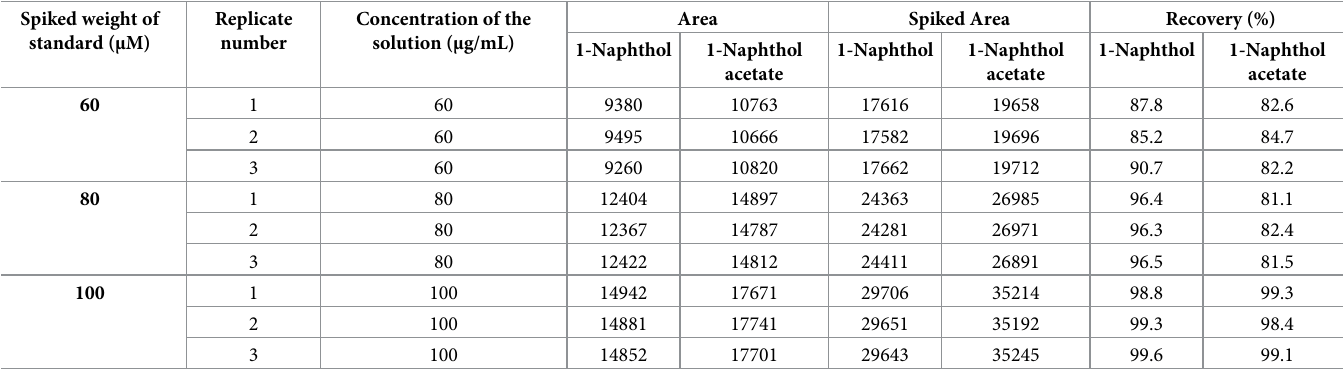
Table 2. Recoveries of 1-naphthol and 1-naphthol acetate on the developed method. Spiked weight of Replicate standard ( μ M)